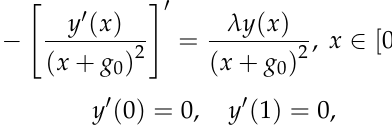
Table 5. Comparing the eigenvalues for Example 5 with the present BSFM using 𝐵 0 = 1 to the exact ones.